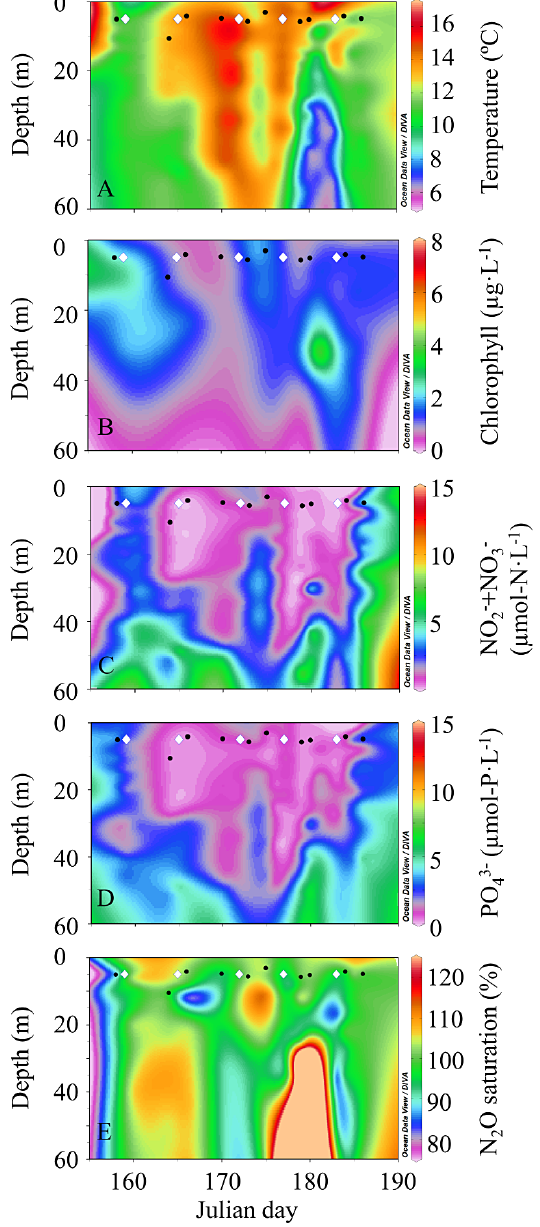
Figure 3. Contour plots of temperature (a) , chlorophyll (b) , + NO − NO − (c) , PO 3 − (d) and N 2 O saturation (e) derived during 3 2 4 the cruise track. The position (Julian day and sample depth) of ob- servational and bioassay stations is indicated by black circles and white diamonds (sequentially E1–E5) respectively.